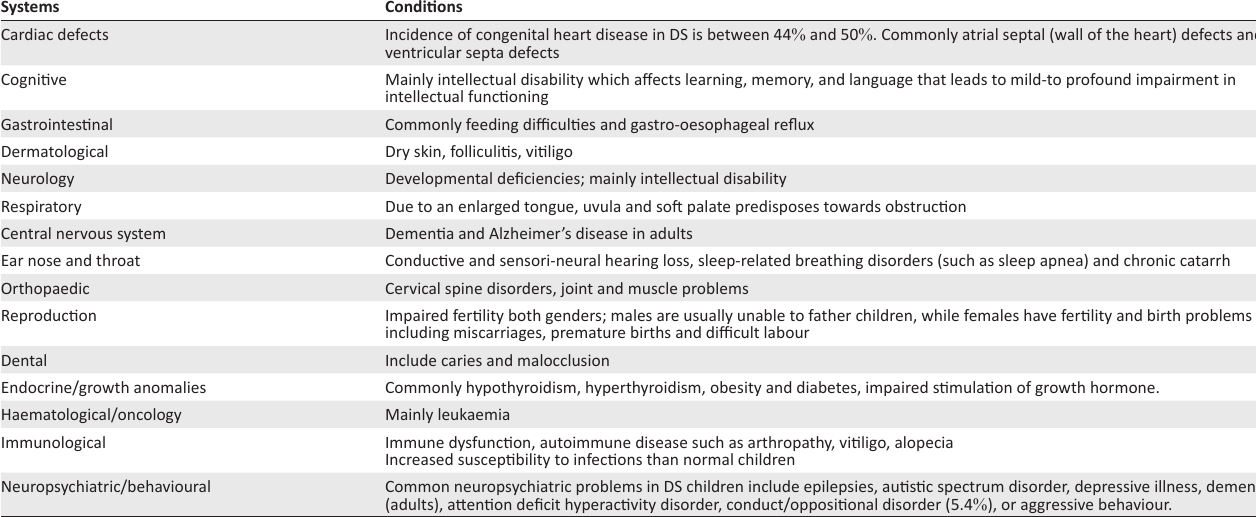
TABLE 2: Health implications of Down syndrome.